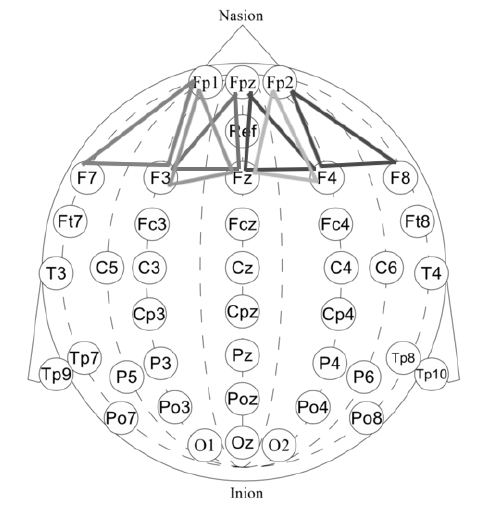
Figure 4. Frontal lobe electrode grouping. Frontal channels (electrodes) were grouped into four sets of three electrodes, taking into account the proximity and location to one side of the reference